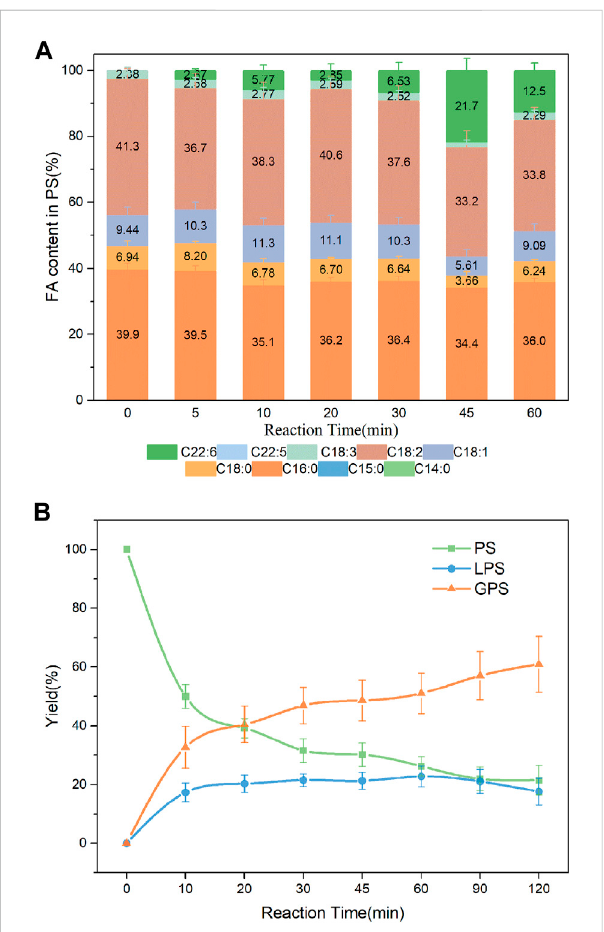
FIGURE 9 (A) Pro fi les of FA in the product PE; (B) Yield of PE in PLA1- mediated transesteri fi cation of PE with DHA-TAG; Reaction conditions: 20 mg PE, 1.0 g algae oil, 10 µL PLA1, 45 ° C, 500